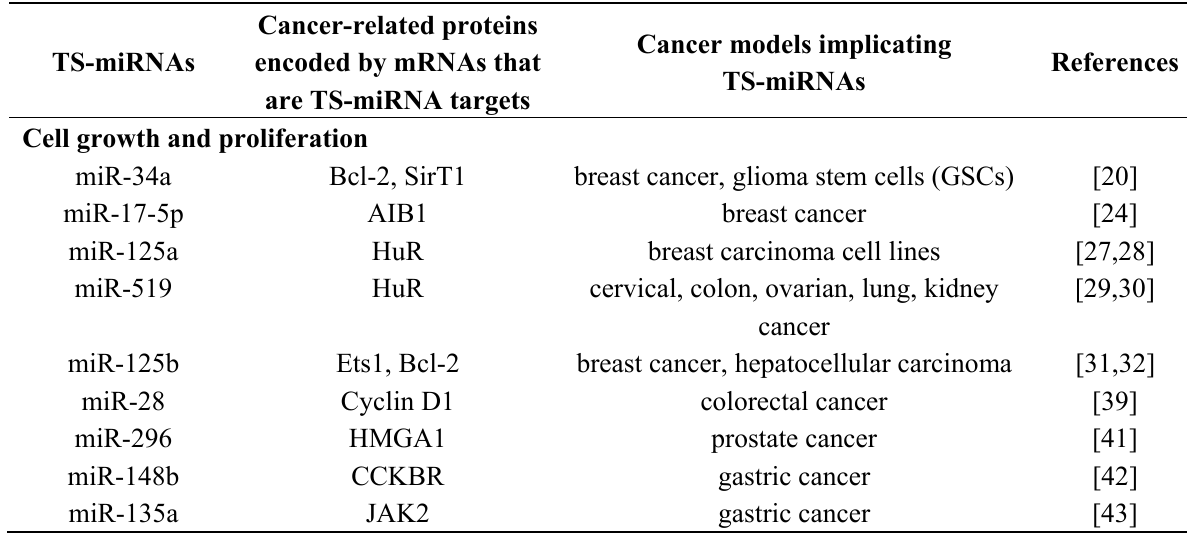
Table 1. Tumor-suppressive miRNAs (TS-miRNAs) involved in oncogenic traits. The table lists the TS-miRNAs discussed in this review, categorized by cancer trait (column 1), the oncogenic proteins encoded by TS-miRNA target mRNAs (column 2), the tumors in which TS-miRNAs have been characterized (column 3) and representatively referenced (column